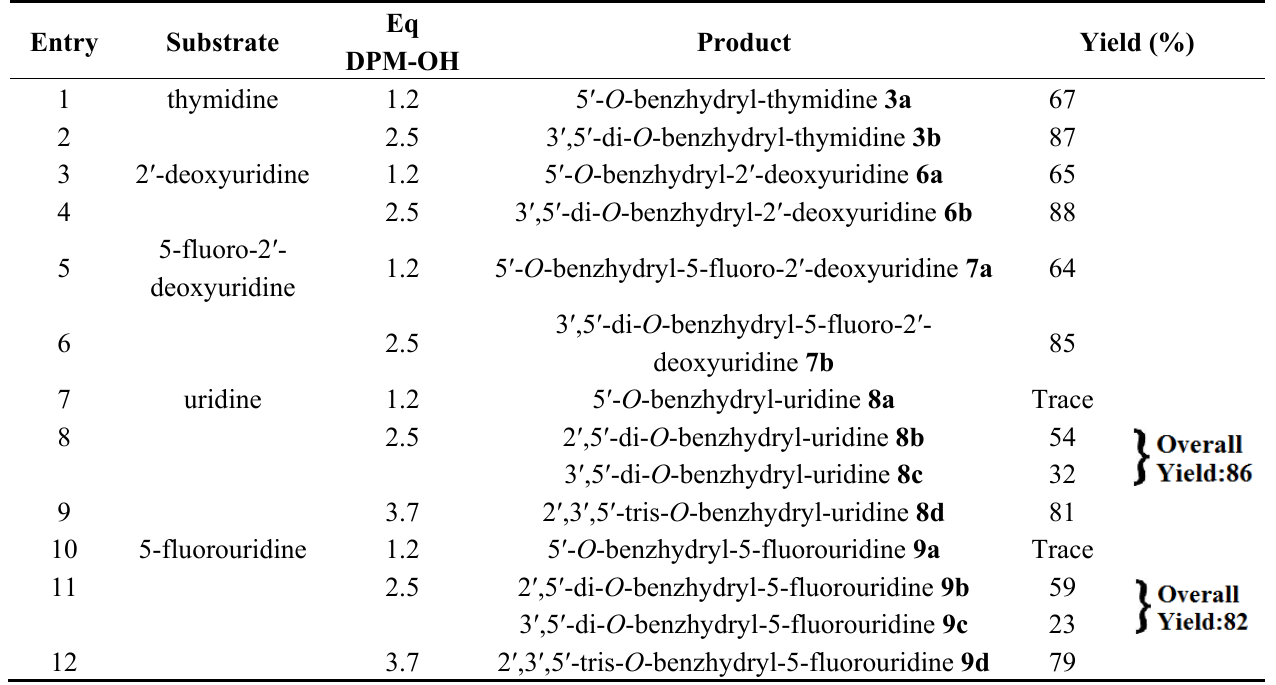
Table 3. Synthesis of different benzhydryl protected